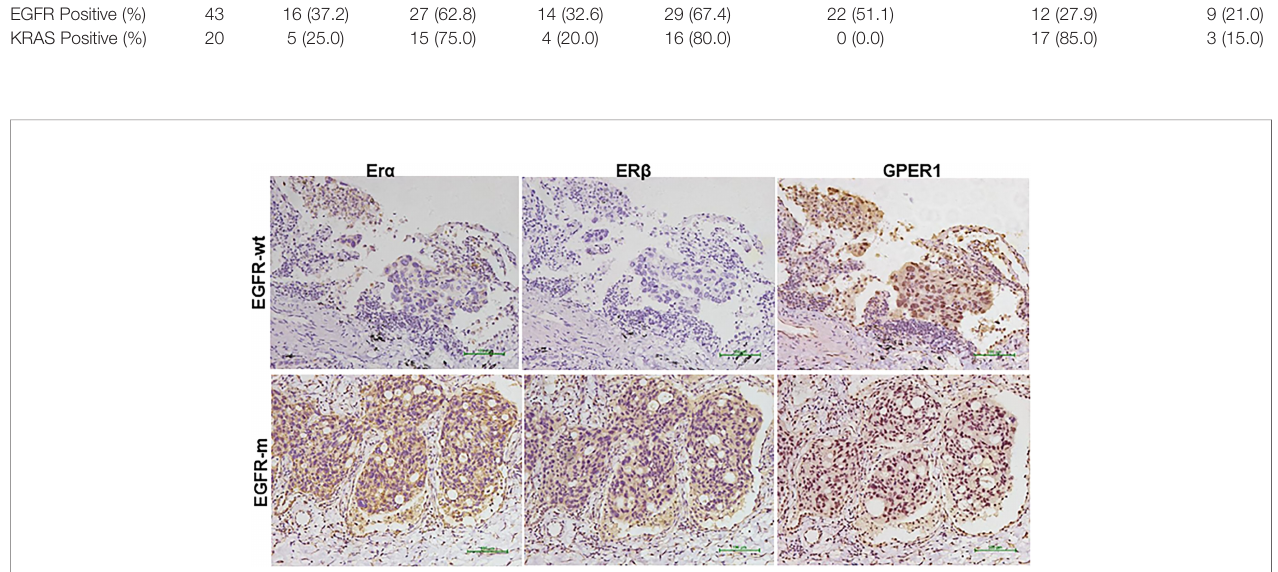
FIGURE 1 | Representative immunohistochemical staining pattern of estrogen receptor (ER) a , ER b , and G-protein-coupled estrogen receptor 1(GPER1) in EGFR mutated (EGFR-m) and EGFR wild type (EGFR-wt) but KRAS mutated tumors